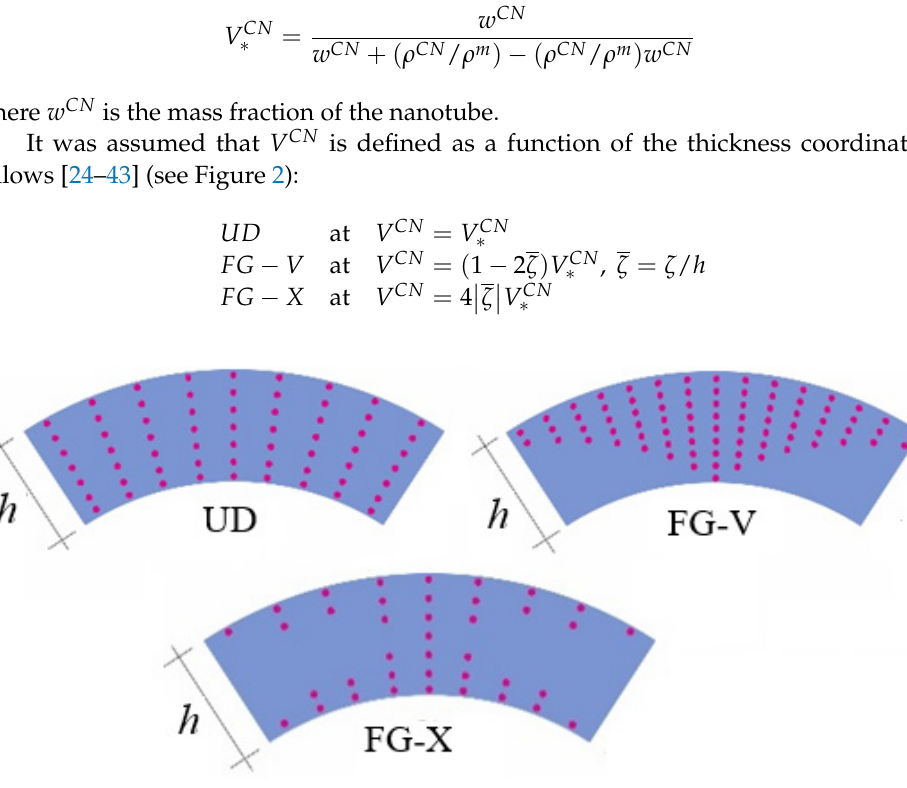
Figure 2. Different distribution patterns of CNTs: UD; FG-V; FG-X.